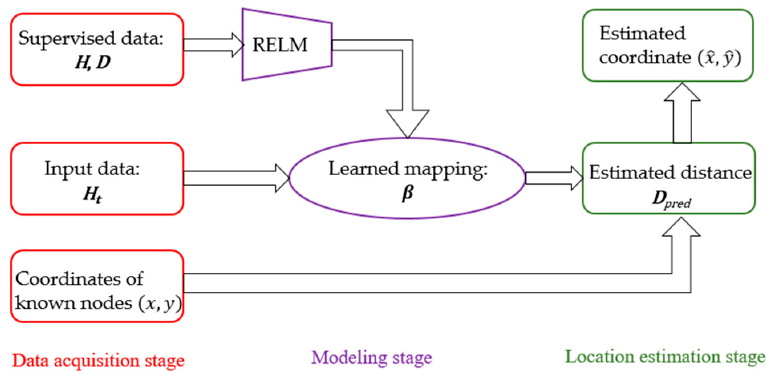
Figure 4. The framework of proposed algorithm. The mapping is firstly trained by REML, using supervised data consist of the known hop-counts and physical distances. After that, in the testing phase, the physical distances of the unknown node are predicted by the learned mapping.